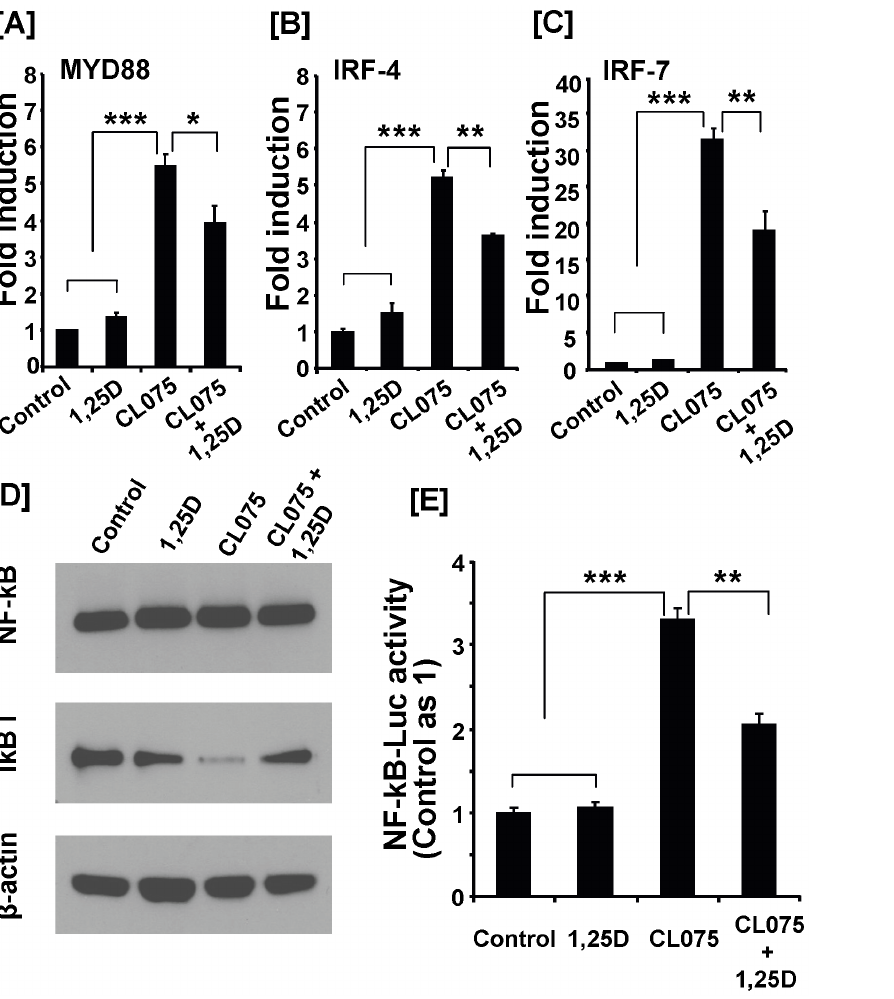
Figure 7. 1,25(OH) 2 D 3 inhibits TLR8 agonist-induced expression of key mediators of TLR8 signaling in human monocytes. ( A–C ) THP-1 cell treatment was described in Figure 5A–B legend. Cells were collected and subjected to RNA and protein extraction. mRNA levels of MyD88 ( A ), IRF-4 ( B ) and IRF-7 ( C ) were determined by real-time RT-PCR. Data represent means 6 SEM (n=4) and are representative of three independent experiments. ( D ) Western blotting for NF-kB and IkB-I protein detection was performed on total cell lysates from THP-1cells stimulated with CL075 (1 m g/ml) in the presence of vehicle or 1,25(OH) 2 D 3 (100 nM) for 20 h. Representative results were obtained from two independent experiments. ( E ) The THP-1 cells were co-transfected with NF-kB promoter luciferase and TK-Renilla plasmid ( Materials and Methods ). After 24 h, the cells